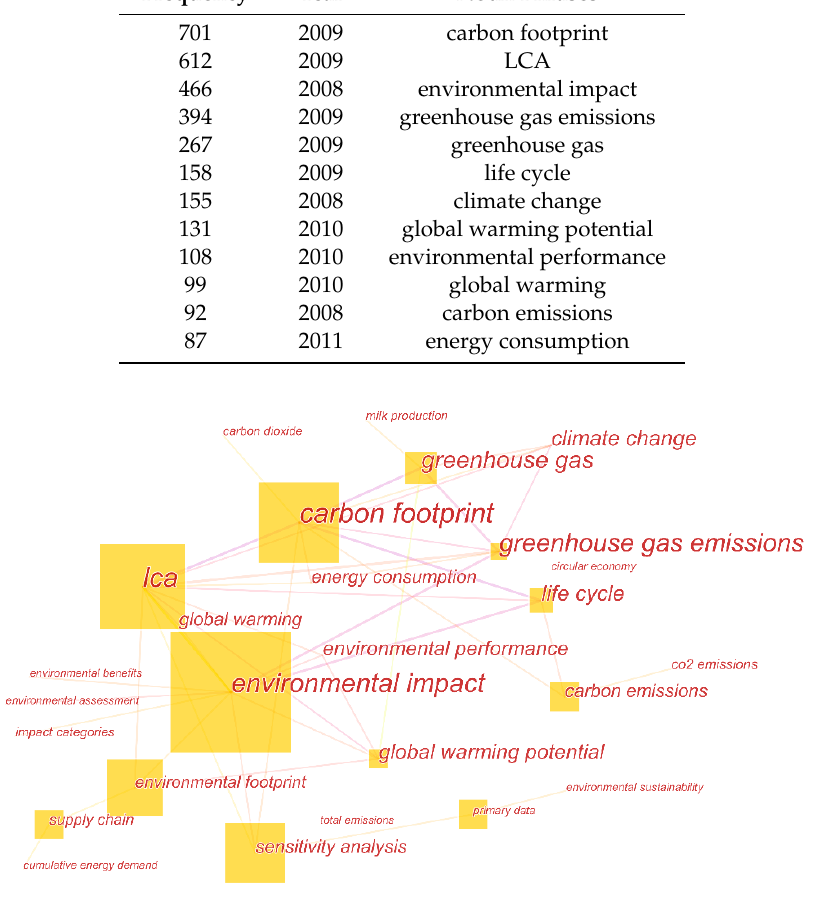
Figure 3. Streamlined noun term co-occurrence network.